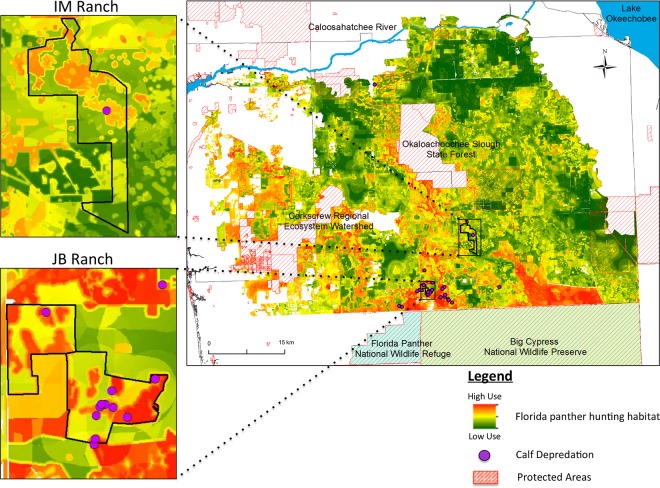
Florida panther hunting habitat model created with MaxEnt, showing the probability of panther presence at night on private lands within the primary, secondary, and dispersal habitat zones in southwest Florida.Inset maps display JB Ranch and IM Ranch study areas with calf depredation sites (ranch maps not to scale). Corkscrew Regional Ecosystem Watershed and Okaloachoochee Slough State Forest were not included in analysis because landcover differs substantially from private lands.